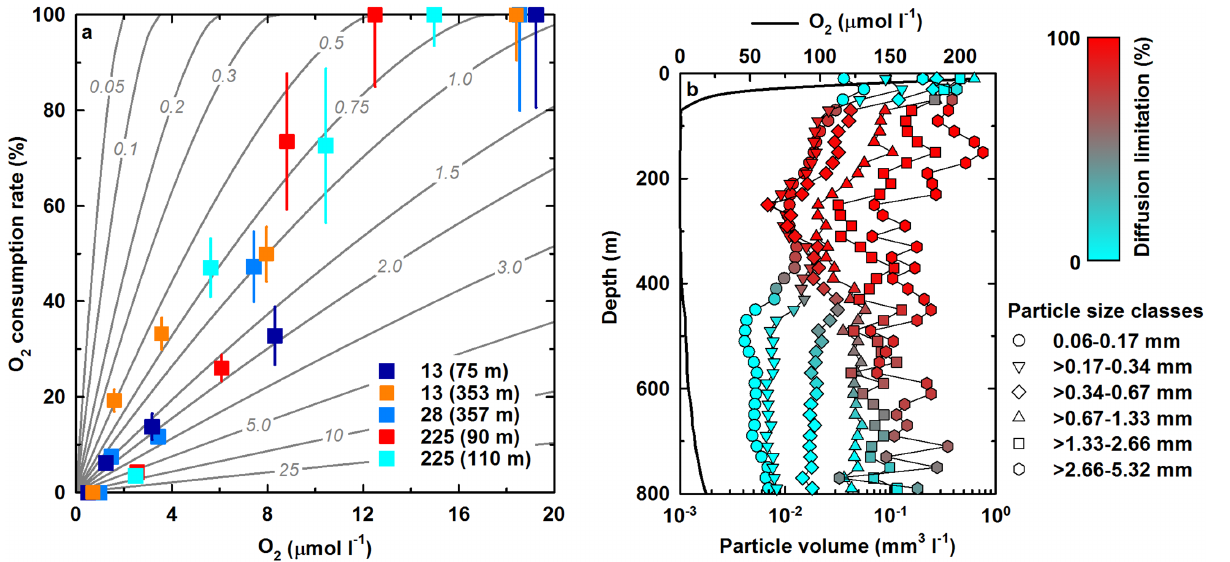
Fig 3. Oxygen sensitivity of aerobic respiration and OMZ particle size distributions. (a) O 2 sensitivity assays in the Namibian (station 225) and Peruvian OMZ (stations 13 and 28) during cruises M76 and M77-3, respectively. Oxygen consumption rates are given as percentages of the highest rate observed (= 100%) among all O 2 treatments (see S2 Table for absolute rates). Error bars for O 2 consumption rates are standard errors calculated from linear regression. Isolines (grey) indicate diffusion-limited respiration rates inside aggregates of 0.01 – 25 mm in diameter. A detailed description of how aggregate- size-dependent rates were calculated is included in the S1 File. (b) Vertical distribution of particle volumes (20 m bins) for six size classes between 0.06 and 5.32 mm (ESD) in the central Peruvian OMZ (12.62°S/77.55°W) during cruise M93. Color shading indicates diffusion limitation of aerobic respiration inside particles. For clarity, particles > 5.32 mm are not depicted here. A more general overview of particle size distributions in the ETSP OMZ is given in S2 Fig.